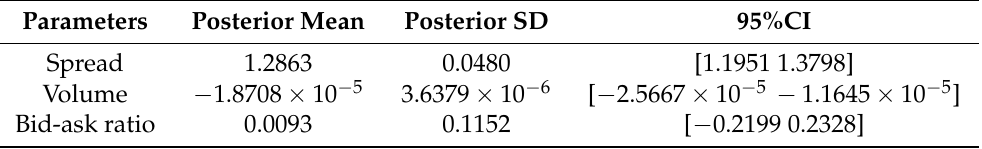
Table 10. Estimated parameters about limit order book (27 July 2016, TMC, Aichi, Japan).